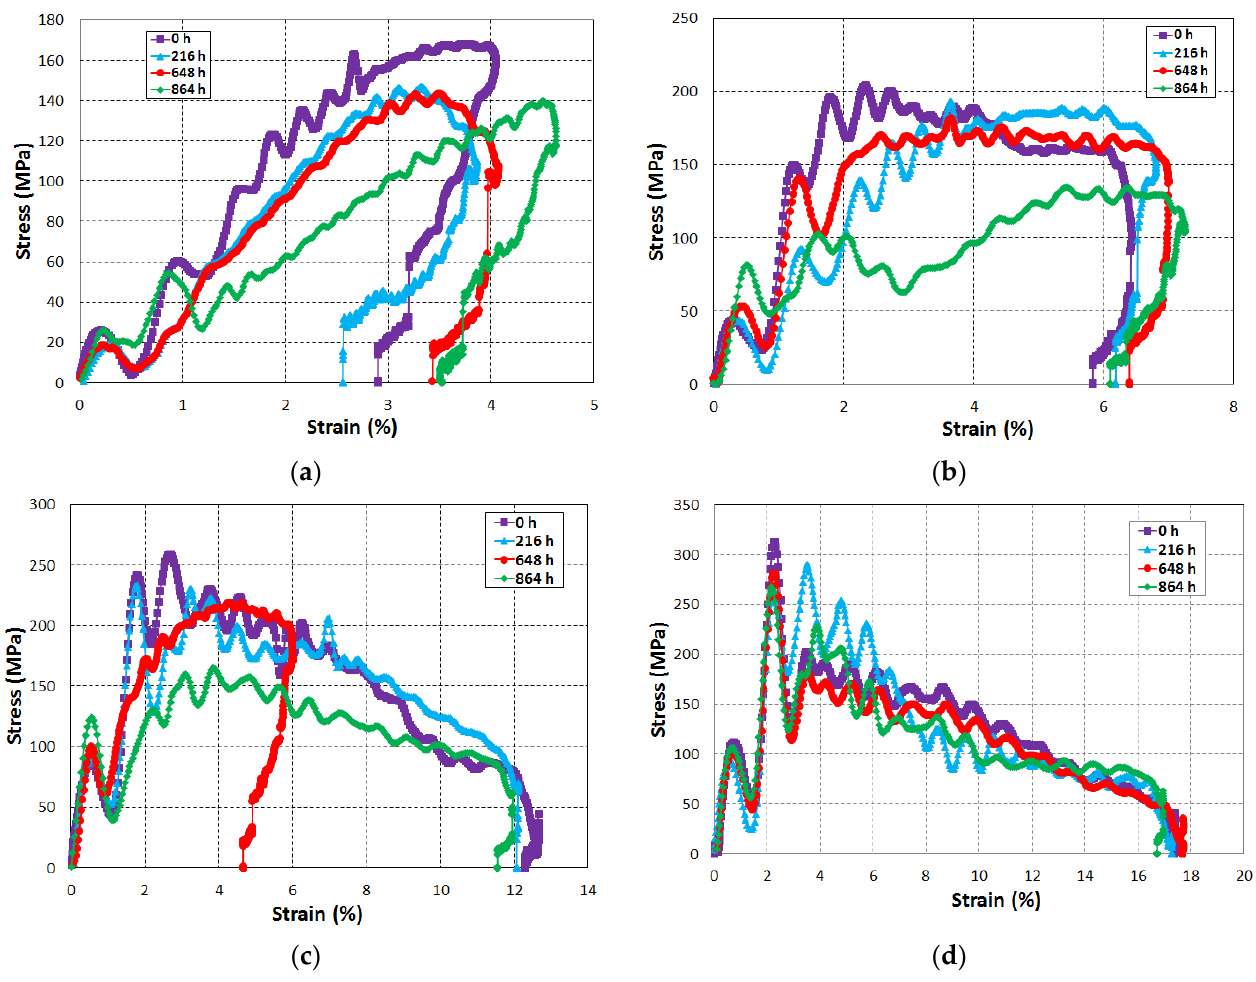
Figure 7. Stress/strain curves of the sample under in-plane loading for different pressure and aging times. ( a ) 1 bar. ( b ) 2 bar. ( c ) 3 bar. ( d ) 4 bar.